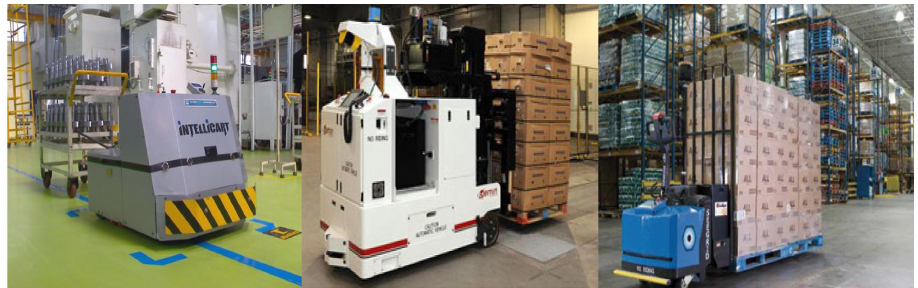
Figure 9. Example of AGV robots